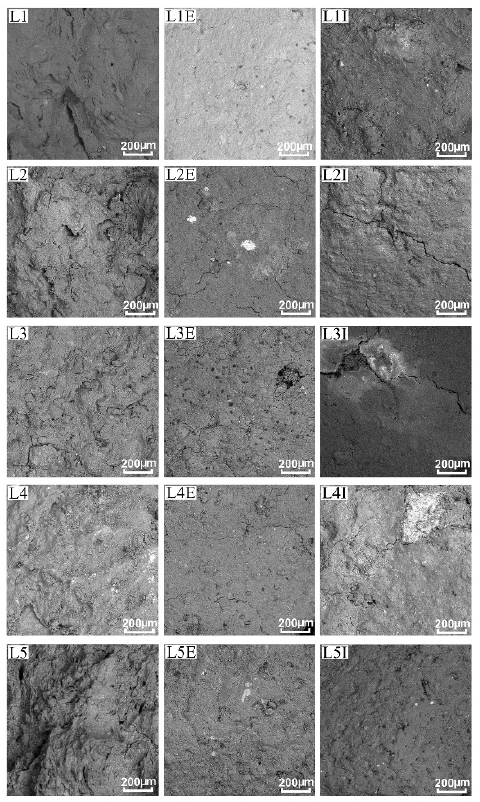
Figure 7. SEM micrographs for the Costi ș a ceramic fragments (L1–L5) from Piatra Neam ț – Lut ă rie. In most samples (L2, L3, L5, L6, L7, L9, L10), individualized mineral particles are visible, with a low homogeneity, and in other samples, traces of vegetal fibers were noticed (L7, L10), aspects that suggest relatively low firing temperatures. The SEM images also show elongated and flattened pores, present in five samples (L1, L5, L8, L9, L10), which indicate using the coiling technique in making the vessels